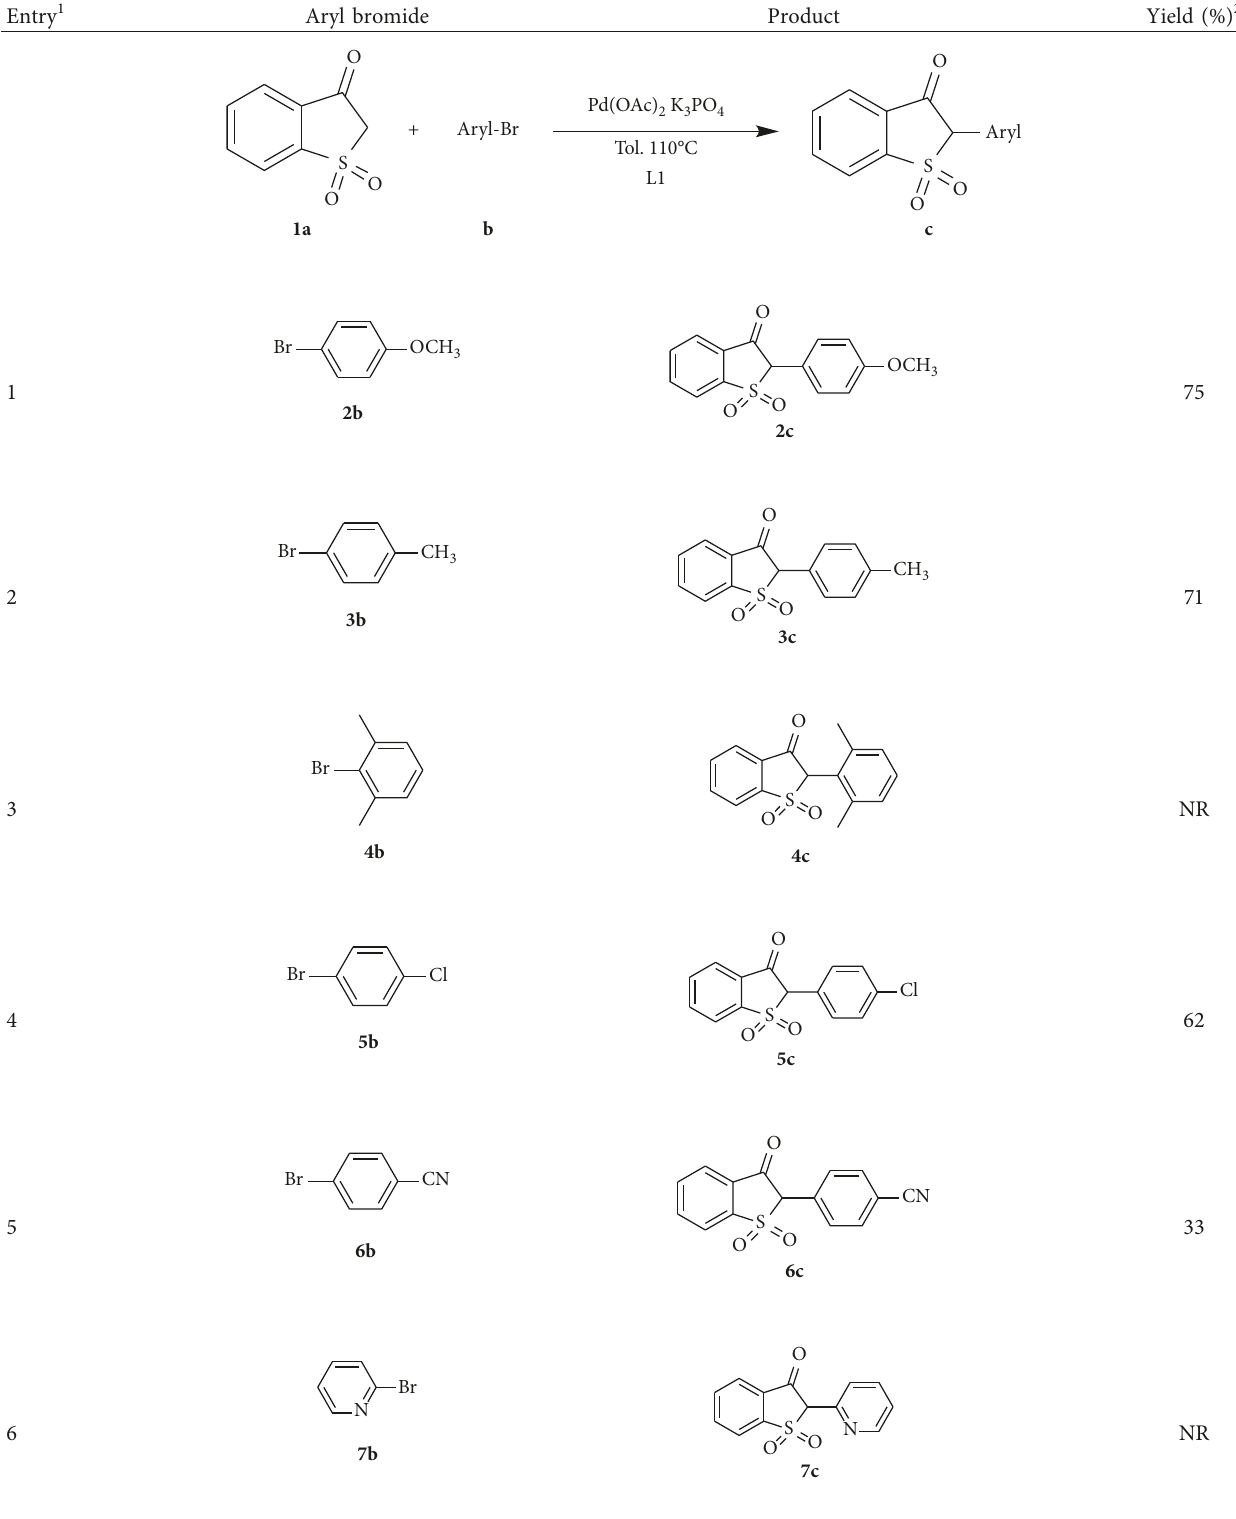
Table 3: The scope of aryl